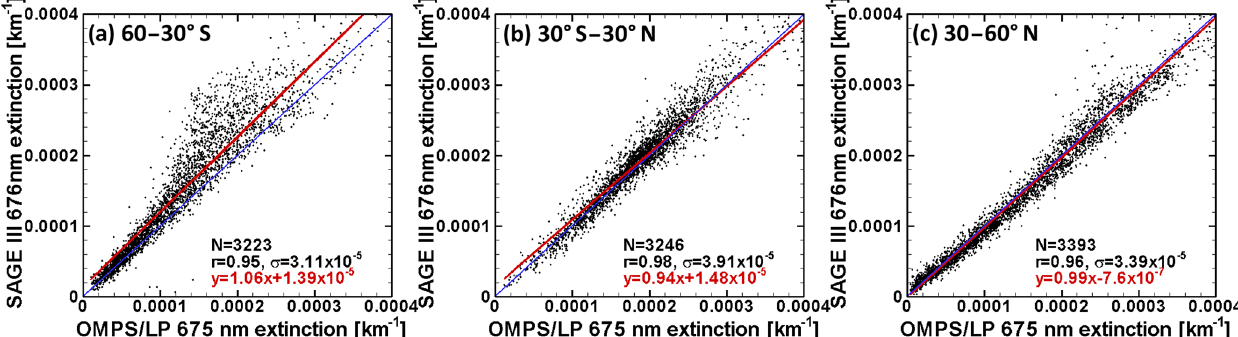
Figure 12. Scatter plot of the SAGE III/ISS and OMPS/LP daily zonal means of extinction values between 19.5 and 27.5km for 60– 30 ◦ S (a) , 30 ◦ S–30 ◦ N (b) , and 30–60 ◦ N (c) for the entire time period from June 2017 to May 2019, illustrating the correlation between the two instruments. The red line shows the linear regression between the data points, and the blue line represents a 1 : 1 relationship. The correlation coefficient r , the standard deviation of the differences ( x − y ) σ , and the number of elements N used to compute r are also